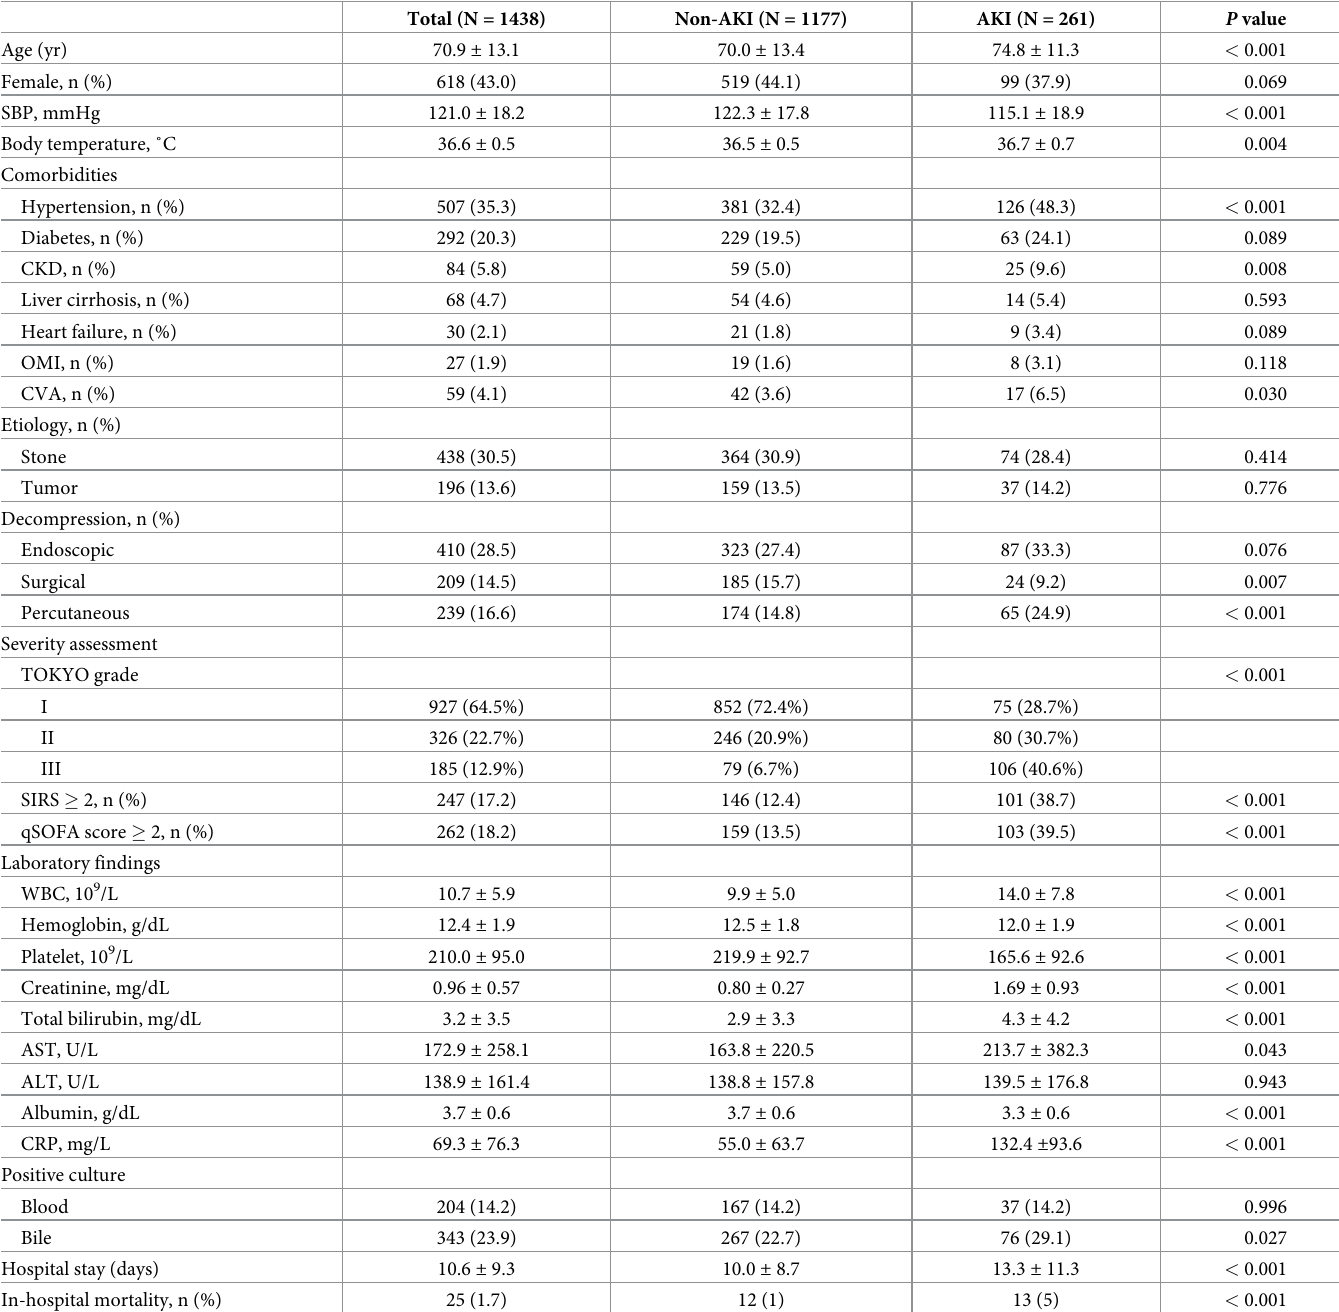
Table 1. Baseline characteristics for acute kidney injury in patients with acute